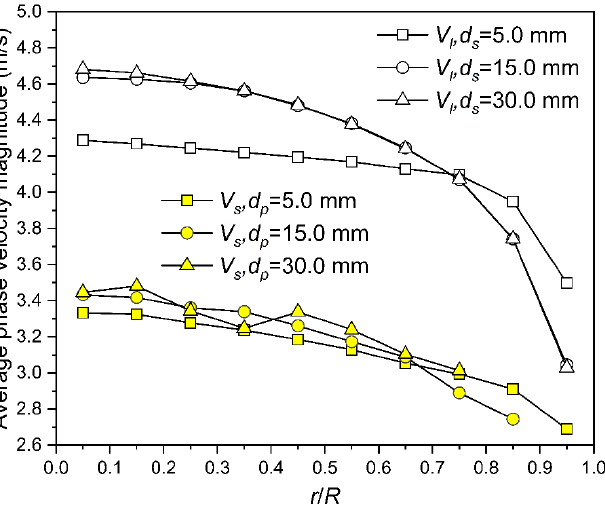
Figure 10. Effects of particle diameter on average phase velocities ( V mix ,0 = 4.0 m/s, C v ,0 = 5%). Due to interactions between particles and between particles and the pipe wall, the distributions of the slip velocity in radial directions are not uniform, which is implied in Figure 11. However, a general trend indicates that the slip velocity decreases with the increase of the radial distance from the pipe axis. The slip velocity for d s = 5.0 mm decreases sharply near the wall. Overall, the slip velocity decreases as particle diameter increases from 15.0 mm to 30.0 mm, which is in accordance with the conclusion reported in [5].